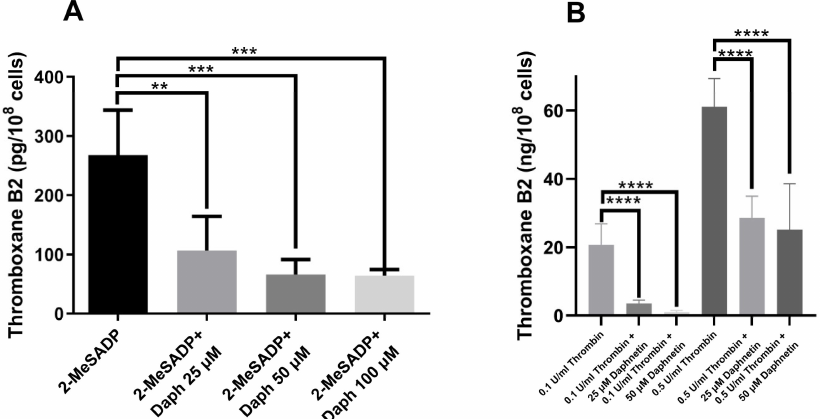
Figure 5. The effect of daphnetin on TxA 2 generation induced by 2-MeSADP and thrombin in platelets. Washed murine platelets were stimulated with ( A ) 100 nM 2-MeSADP and ( B ) 0.1 U/mL and 0.5 U/mL thrombin in the presence of different concentrations of daphnetin at 37 ◦ C for 3.5 min under stirring condition and TxB 2 generation were measured in duplicates by ELISA assay. Data are representative of three independent experiments ( n = 3) and are presented as mean ± SE **, p < 0.01; ***, p < 0.001; ****, p <